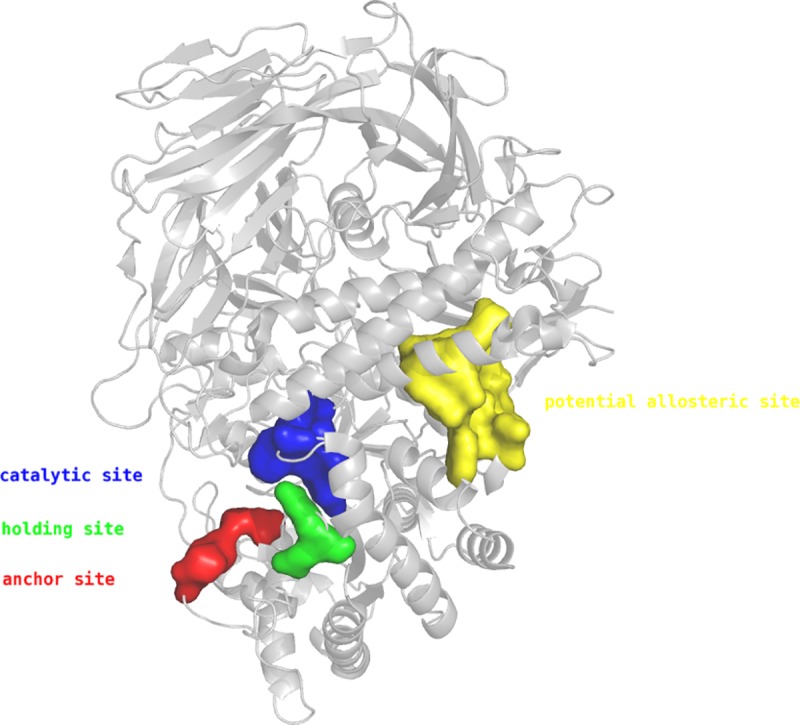
Overview of the different locations of the active site consisting of the catalytic site (blue), holding site (green), anchor site (red) with the potential allosteric site (yellow) within dGMII [3].